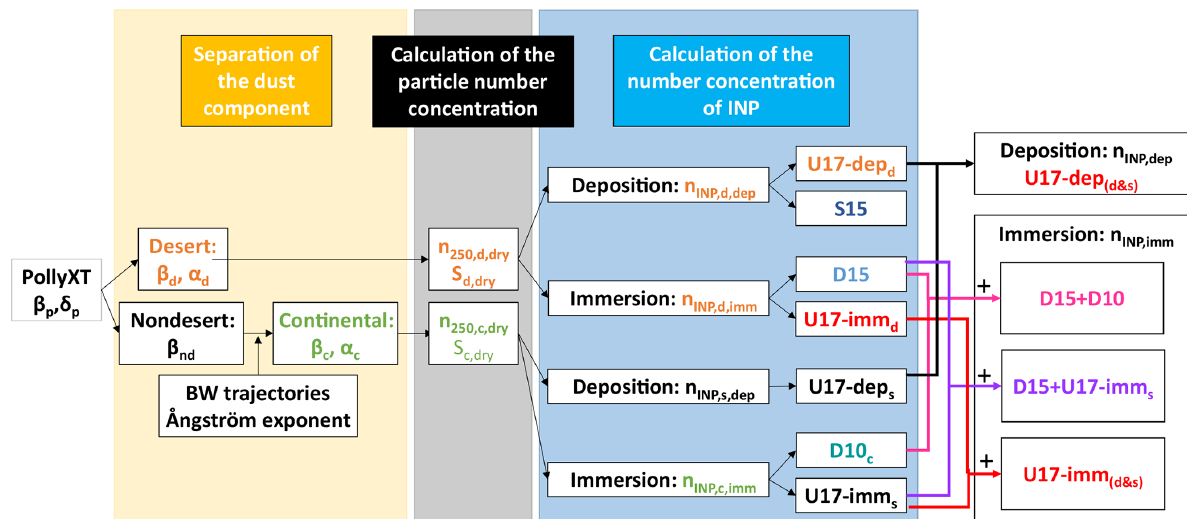
Figure A1. Overview of the data analysis scheme followed for the PollyXT measurements in this work. In the first step, we separate desert and nondesert backscatter coefficients ( β d and β nd ) by means of the particle linear depolarization ratio ( δ p ). The backscatter coefficients for the nondesert aerosol are estimated to be continental aerosol mixtures β c by means of, e.g., backward (BW) trajectory analysis and Ångström exponent information. The two backscatter coefficients are then converted to aerosol type-dependent particle extinction coefficients ( α i ). In the next step, the extinction coefficients are converted to aerosol type-dependent profiles of particle number concentrations ( n 250 , i , dry ) and particle surface area concentration ( S i , dry ). In the next step, ice-nucleating particle number concentrations ( n INP , i ) are estimated by applying INP parameterizations from the literature indicated by D10, D15, S15 and U17 for DeMott et al. (2010, 2015), Steinke et al. (2015) and Ullrich et al. (2017), respectively. Finally, the INP concentrations estimated for the different aerosol types are summed in order to estimate the total n INP